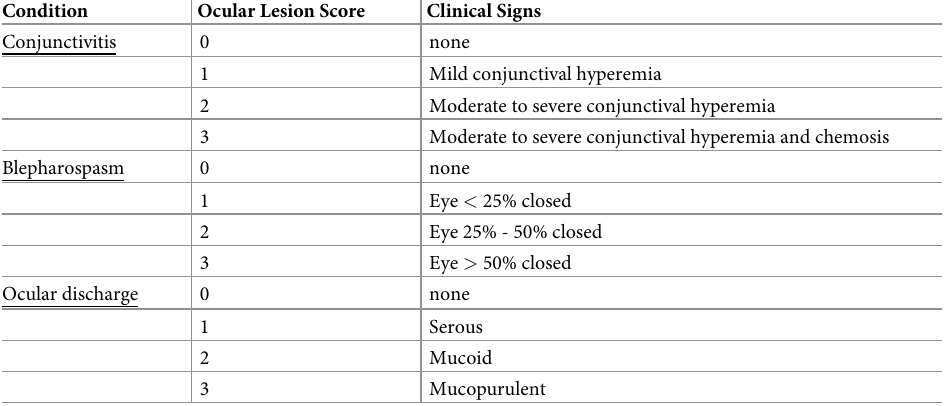
Table 1. Ocular disease scoring